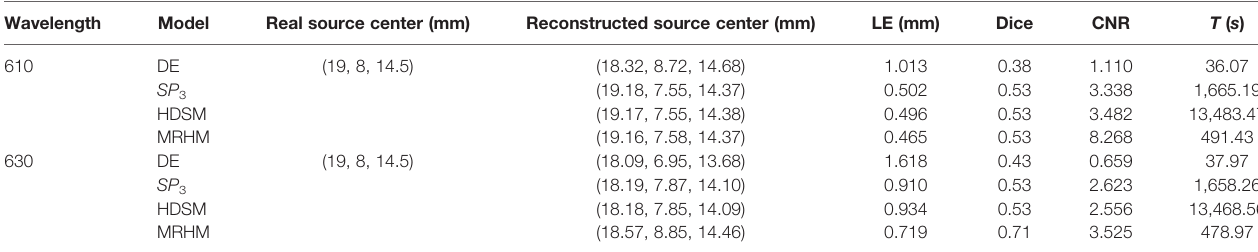
TABLE 3 | Quantitative results in reconstruction